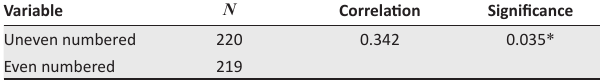
TABLE 2: Split-half reliability